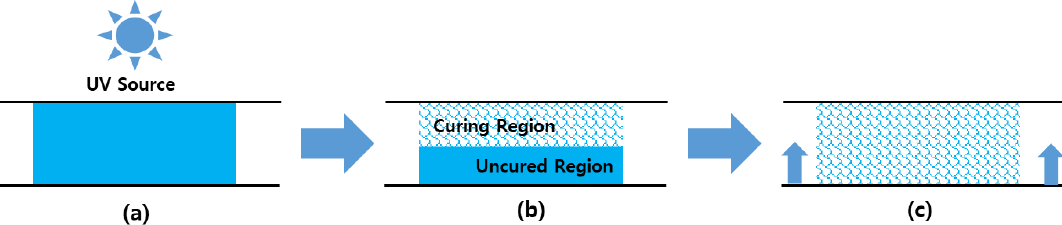
Figure 10. The shrinkage measurement process: ( a ) exposure to light source, ( b ) surface curing/no curing within material (no shrinkage measured), and ( c ) deep curing (start of shrinkage measurement).